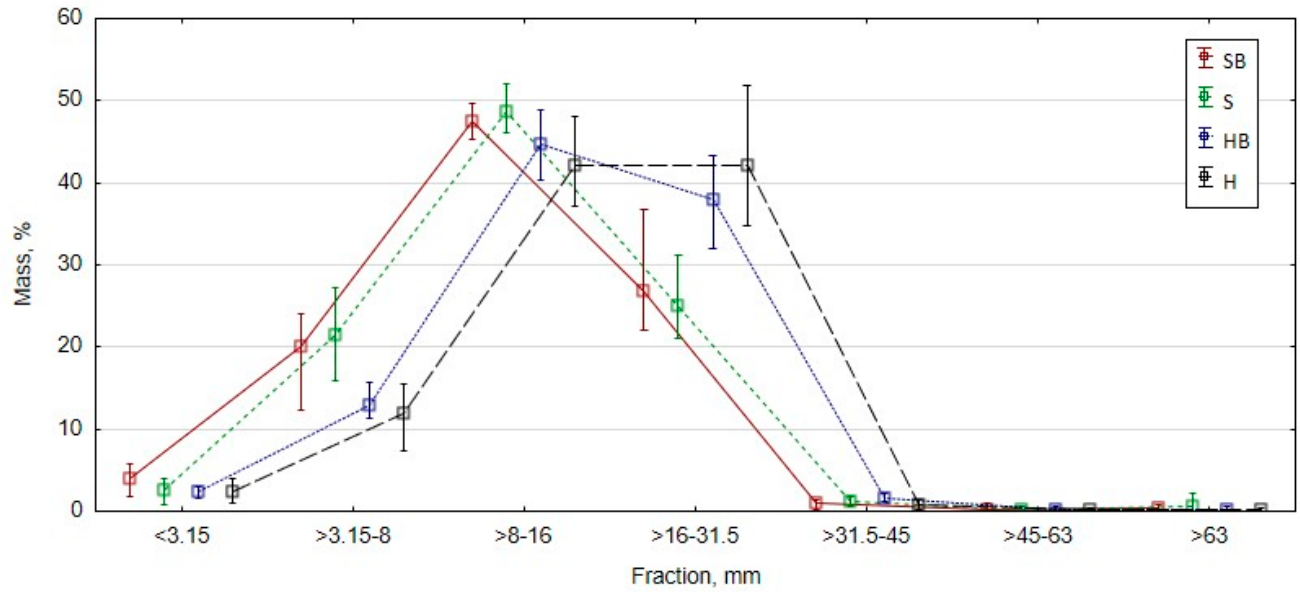
Figure 1. Particle size distribution of the tested samples (Mean; Whisker: Min − Max).